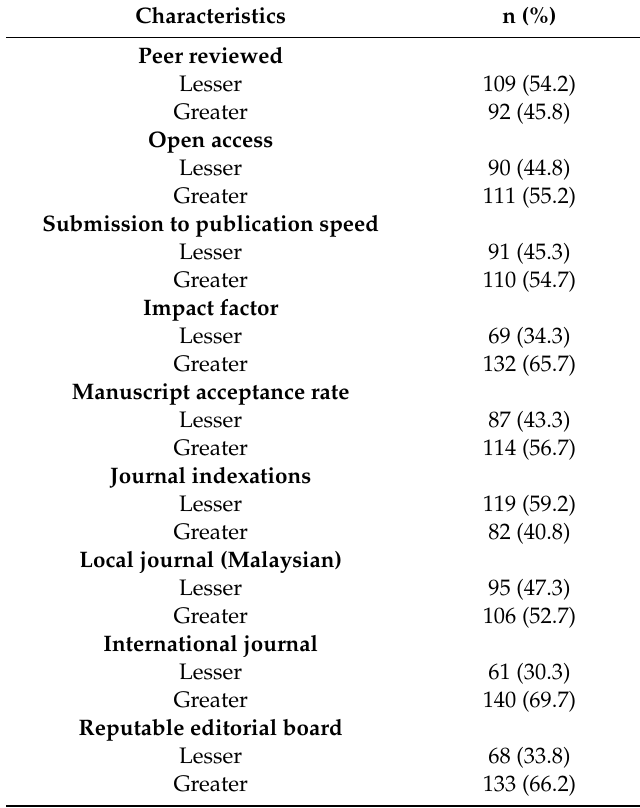
Table 2. Clinicians Journal Selection Attributes ( n =